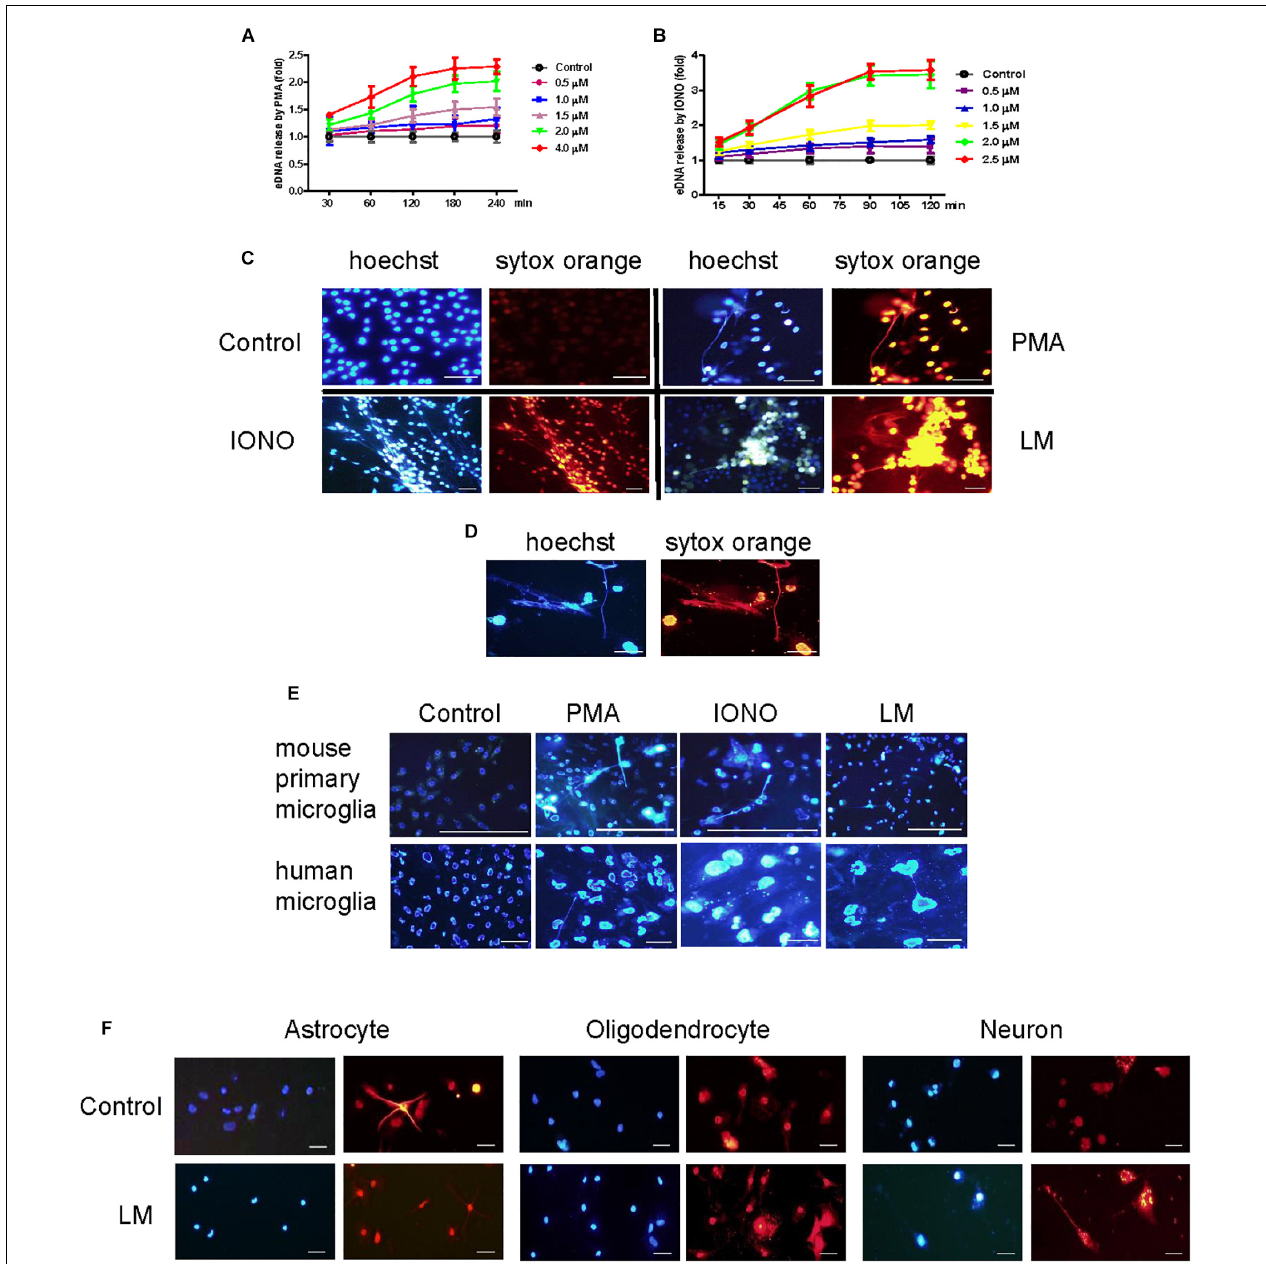
FIGURE 1 | Listeria induced MiETs production. A series of PMA concentrations (0.5–4 µ M) were used to treat the BV2 cells for different times (30–240 min). The cells were stained with 1 µ M Sytox green for 10 min and then detected with a plate reader (A) . Ionomycin at different doses (0.5–2.5 µ M) was used to treat BV2 cells for 15–120 min (B) . PMA (2 µ M), ionomycin (1.5 µ M) and Listeria (MOI = 50:1) were added to BV2 cells and incubated in 24-well glass bottom plates (2 × 10 5 cells/well). The cells were stained with Hoechst 33342 and Sytox orange and then observed by fluorescence microscopy (C) . The CD8 + T cells (6 × 10 5 cells) were incubated with Listeria-infected (MOI = 50:1) BV2 cells (6 × 10 5 cells) in confocal dish. The cells were stained with Hoechst 33342 and Sytox orange and then observed by fluorescence microscopy (D) . Listeria (MOI = 50:1), PMA (2 µ M) and ionomycin (1.5 µ M) were added to mouse primary microglia and a human microglia cell line and the results were collected by fluorescence microscopy (E) . Listeria (MOI = 50:1) was added to mouse primary astrocytes, oligodendrocyte and neuron and the results were collected by fluorescence microscopy (F) . Scale bars = 50 µ m.